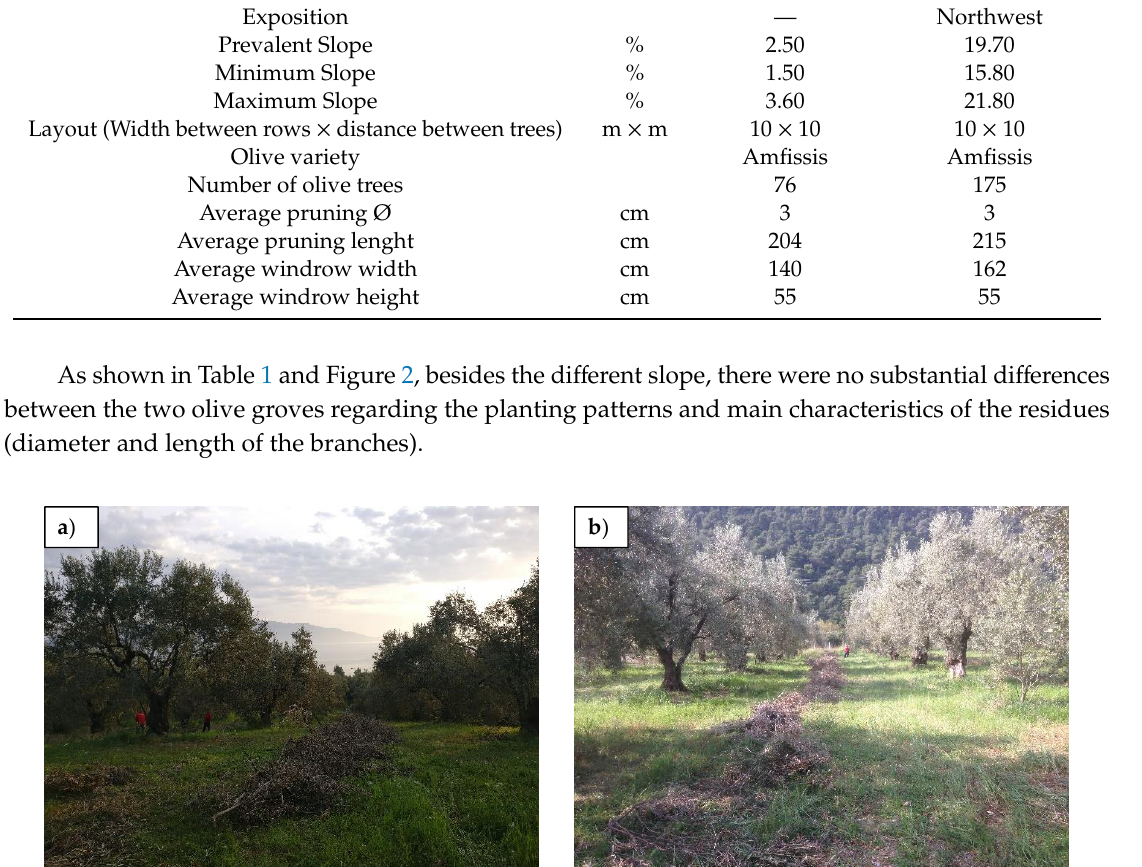
Table 1. Main characteristics of the olive groves.